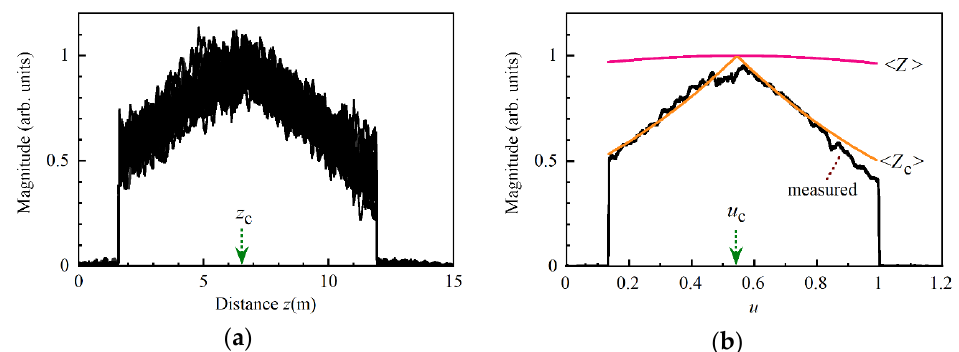
Figure 13. ( a ) Overwrite of 30 reflectograms from a 10 m long polarization-maintaining (PM) fiber. z c ( = 6.51m) is the distance to the center of pumping. ( b ) Mean reflectogram (shown in black), which was derived from the 30 reflectograms shown in ( a ). < Z > is a plot of the Gaussian function defined by Equation (17) with Δ rms = 3.74 × 10 6 rad/s, τ e = 115 ns and u c = 0.545. < Z c > is a plot of Equation (28), which is the product of Gaussian and exponential functions where δν L = 2 MHz.